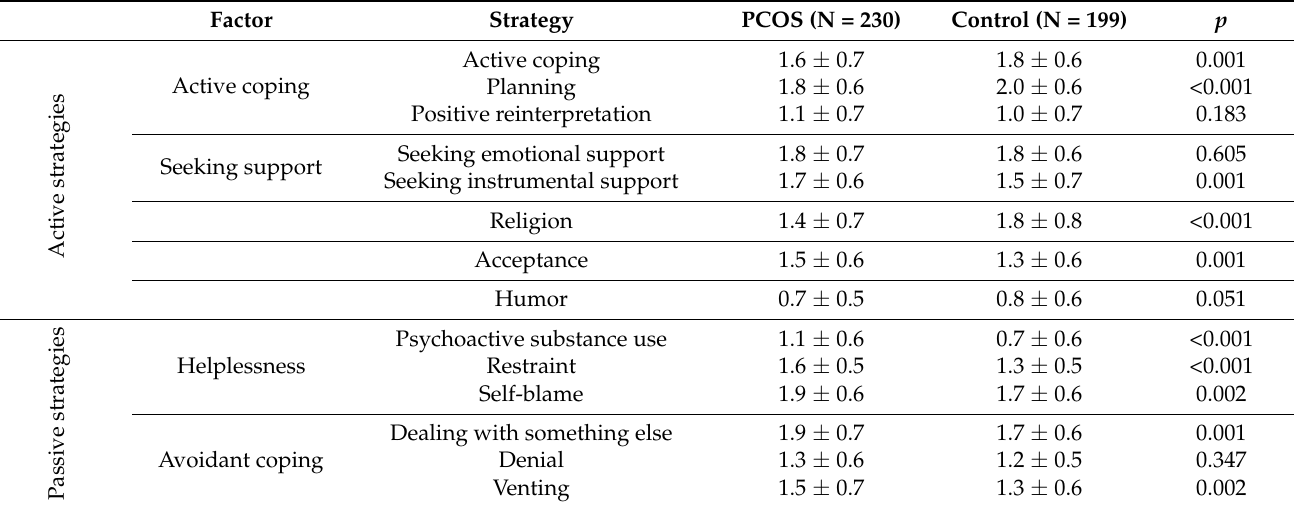
Table 2. MINI-COPE inventory for PCOS group and control